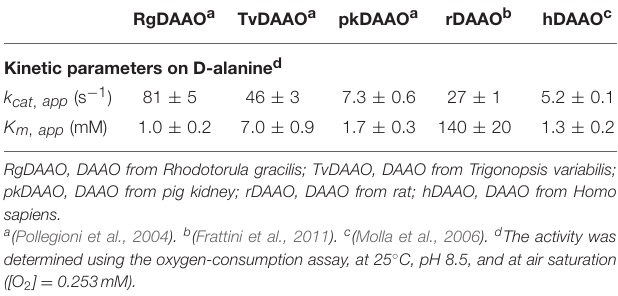
TABLE 1 | Comparison of kinetic properties of DAAO from different organisms. Yeast DAAOs Mammalian